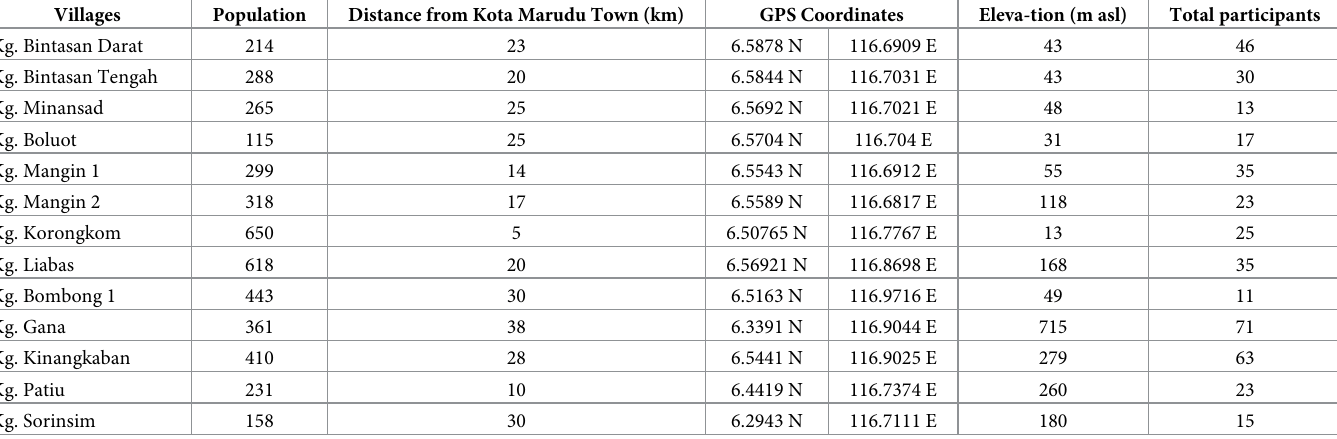
Table 1. Details of the villages in Kota Marudu selected for the study. Elevation of the villages is given as metres above sea level (masl). Total participants in the study were 407.